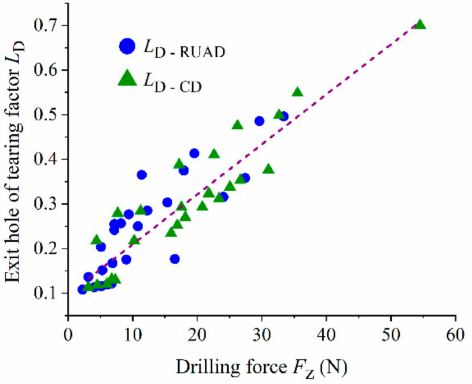
Figure 18. Drilling force versus hole exit tearing